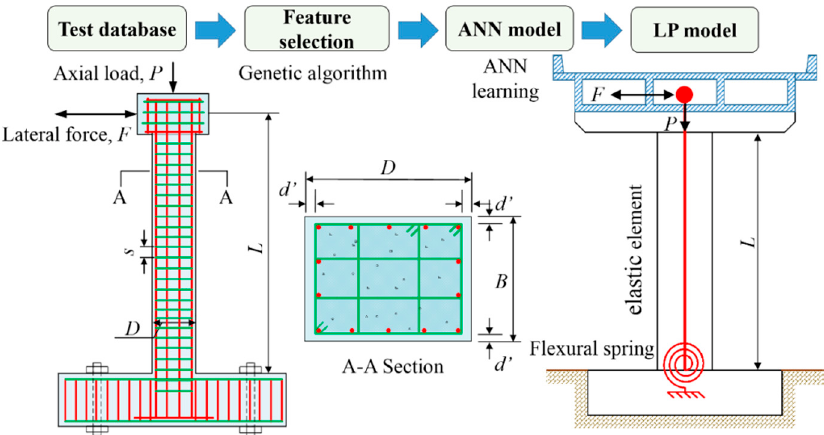
Figure 1. Schematic diagram and lumped plasticity model of a typical RC column.